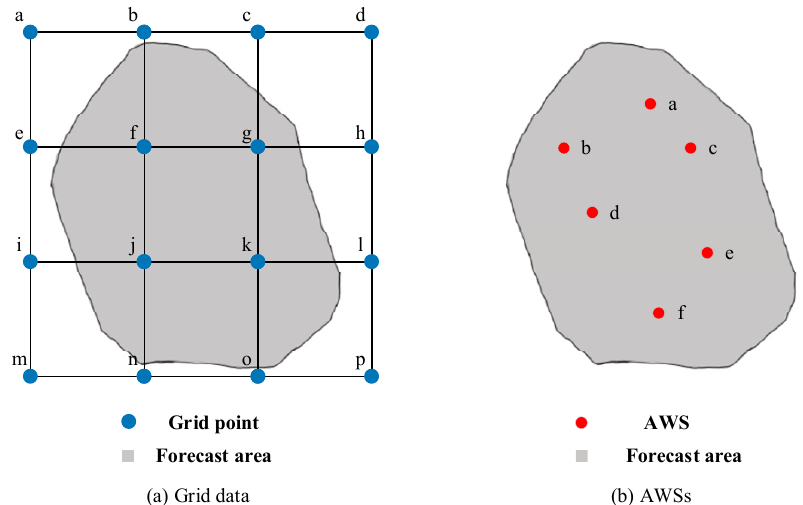
Figure 3. Schematic diagram of the forecast area including ( a ) grid points and ( b ) AWSs.